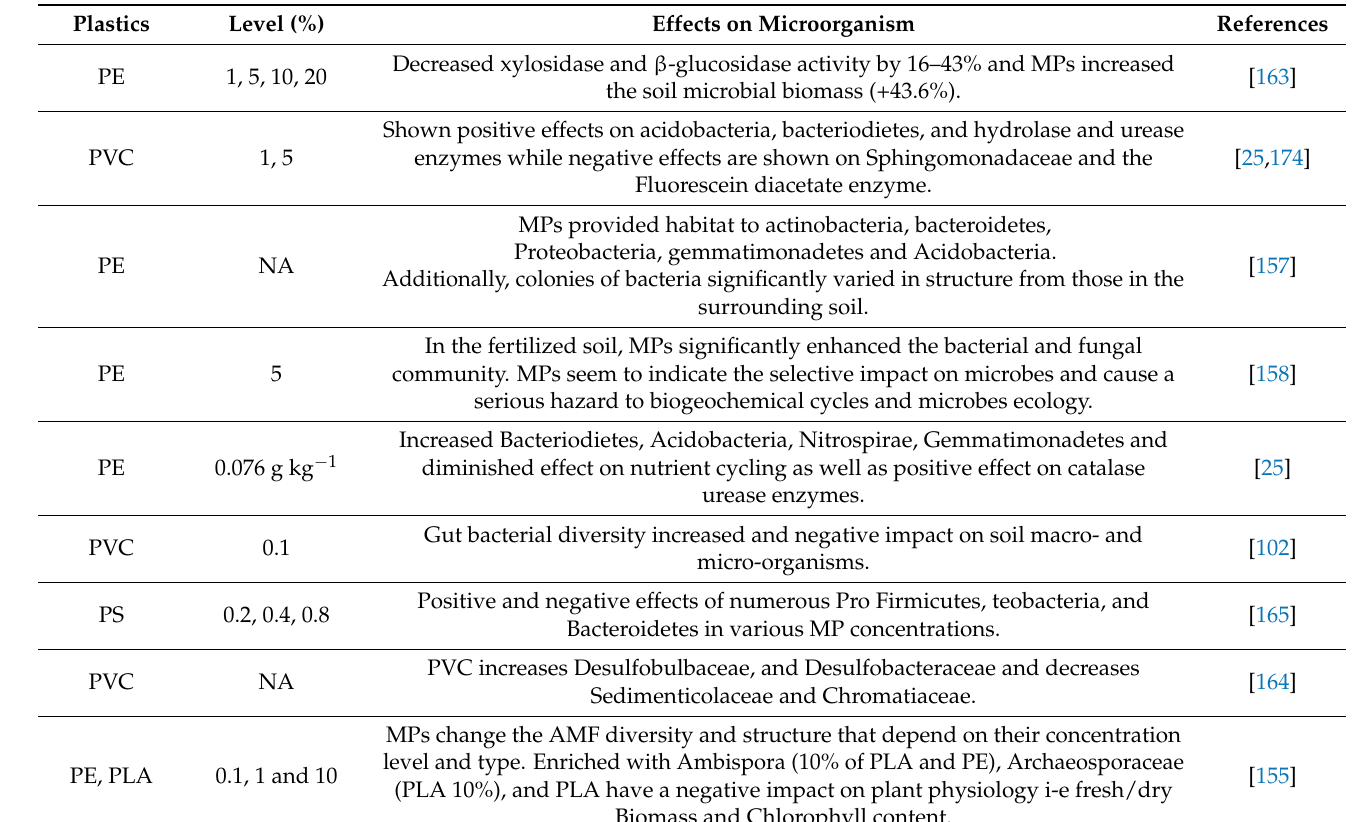
Table 1. The impact of plastics on soil